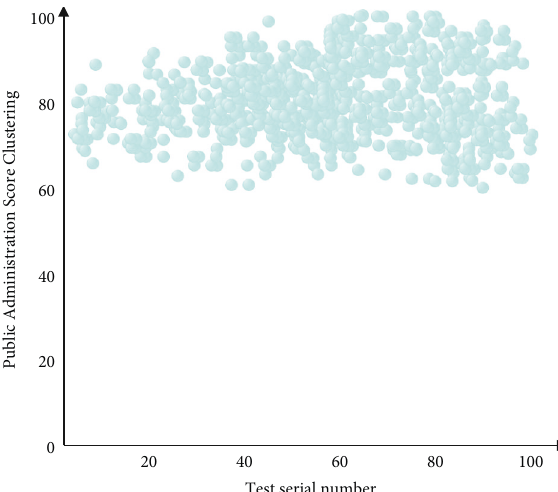
Figure 9: Clustering effect of enhanced regression method in social public management